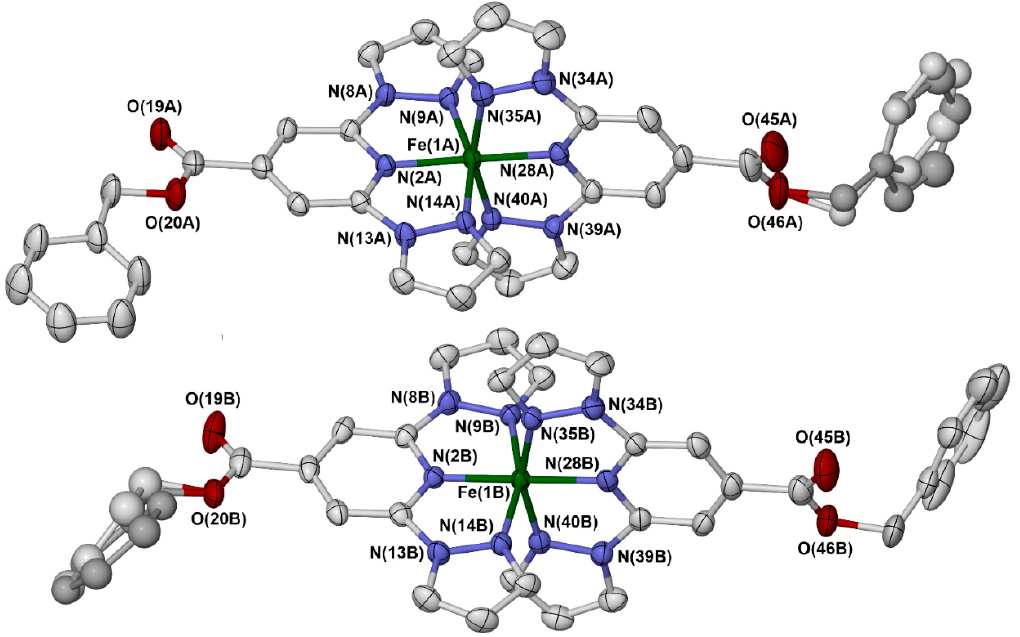
Figure 4. The complex dications in [Fe( L 5 ) 2 ][BF 4 ] 2 · 3 / 2 MeCN, showing the orientations of their benzyl substituents. Benzyl group disorder sites are distinguished with pale and dark colouration. Other details as for Figure 1. Colour code: C, white or grey; Fe, green; N, blue; O, red.